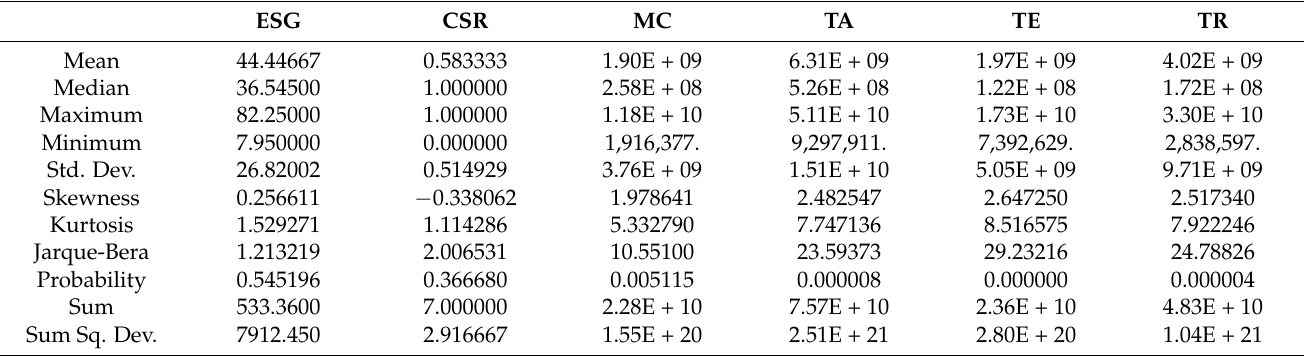
Table 2. Descriptive